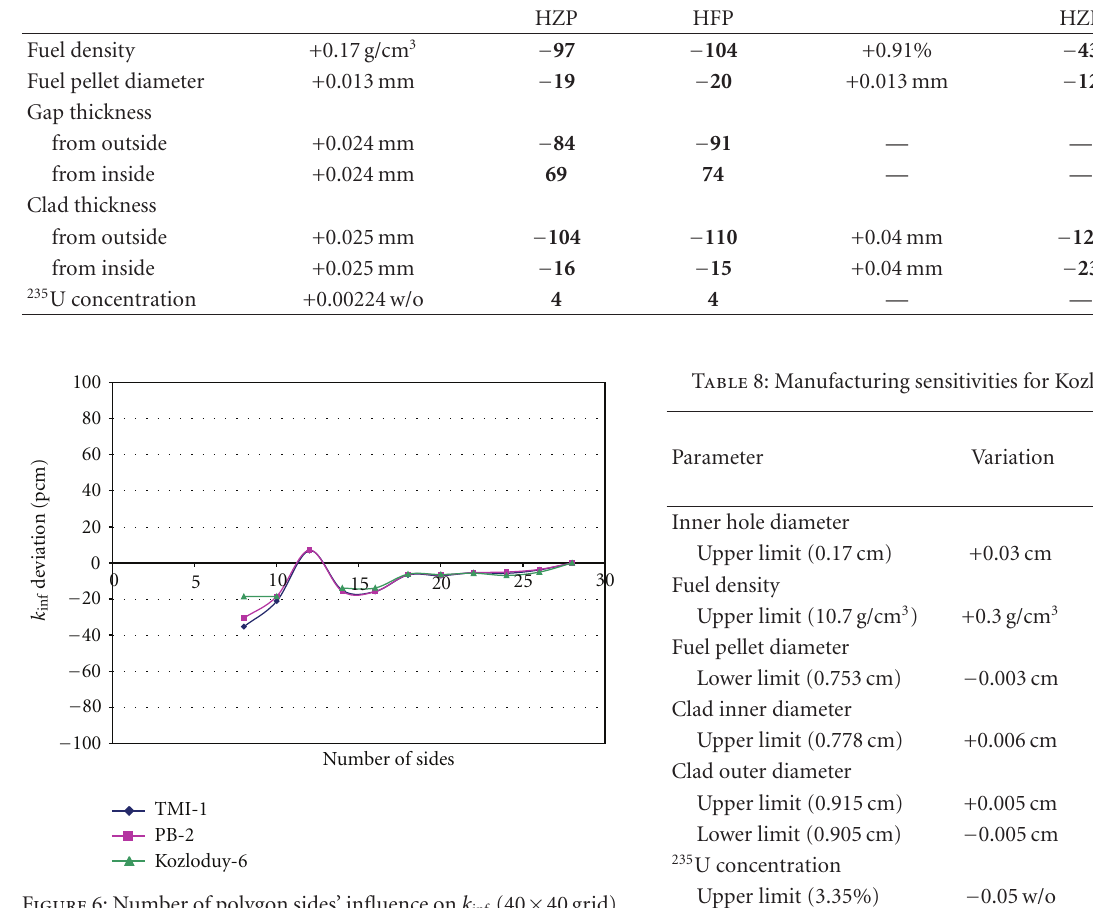
Figure 6: Number of polygon sides’ influence on k inf (40 × 40 grid).